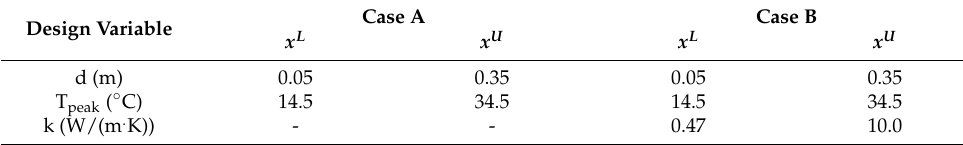
Table 4. Design variables and their ranges for the case